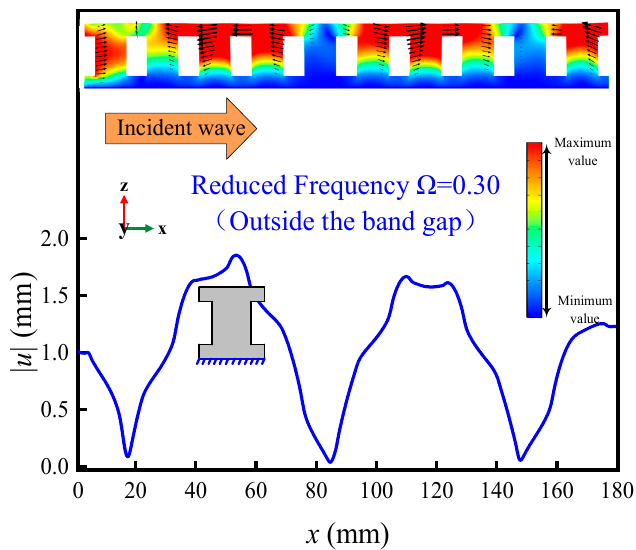
Figure 7. Radial vibration displacement field outside the band gap of the quasi-static REMs.